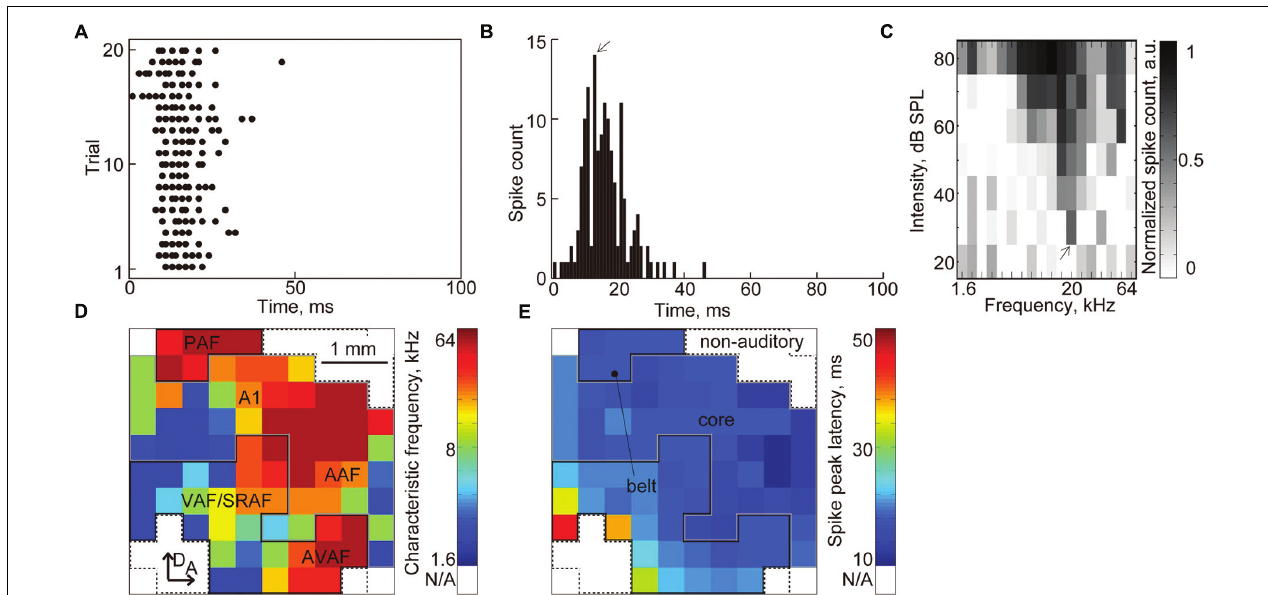
FIGURE 7 | Characterization of the auditory cortex based on the CF and spike peak latency. (A) Representative raster plot. The black dots indicate MUAs. (B) PSTH of the raster plots in (A) . The arrow indicates the peak latency. (C) FRA at each recording sites. The arrow indicates the CF (20 kHz) at this recording site. (D) Tonotopic map and (E) latency map in the auditory cortex. Color map of the CF and spike peak latency at each recording site is shown. From these maps, we classified each recorded site into three functional regions: core, belt, and non-auditory region. The recording sites that had no clear CF were categorized in the non-auditory region. The borders between the core and belt regions were determined from the tonotopic gradient and spike peak